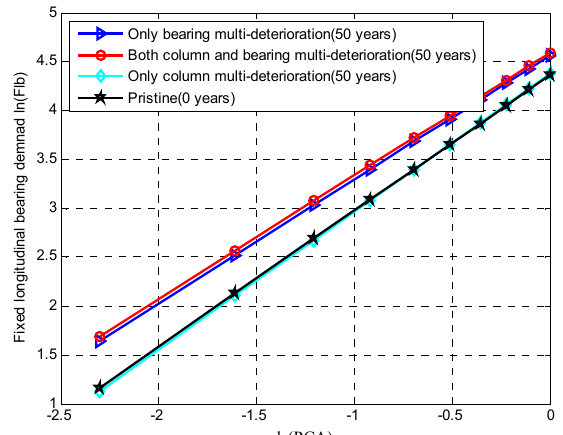
Figure 13. Mean values of the demand placed on a fixed bearing in the longitudinal direction using a PSDM.